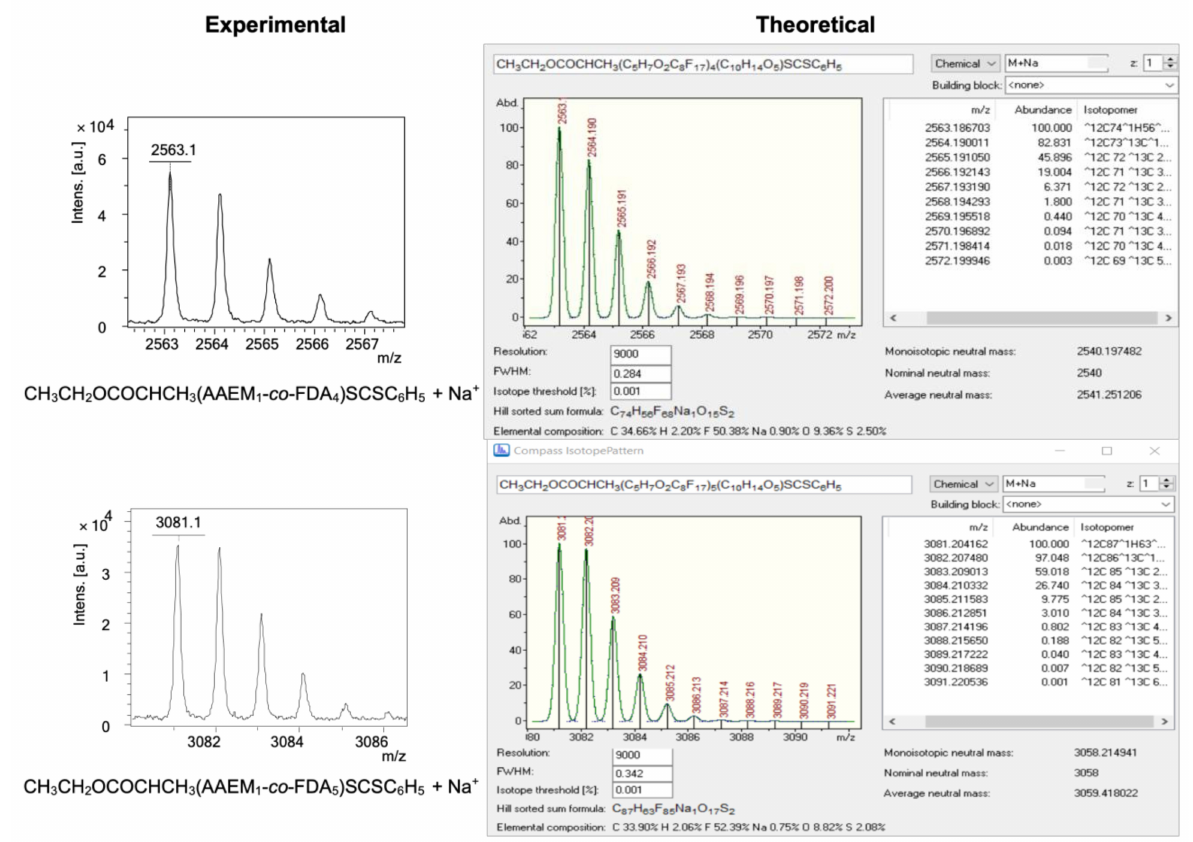
Figure 9. Experimental and theoretical isotope patterns of sodium adducts of CH 3 CH 2